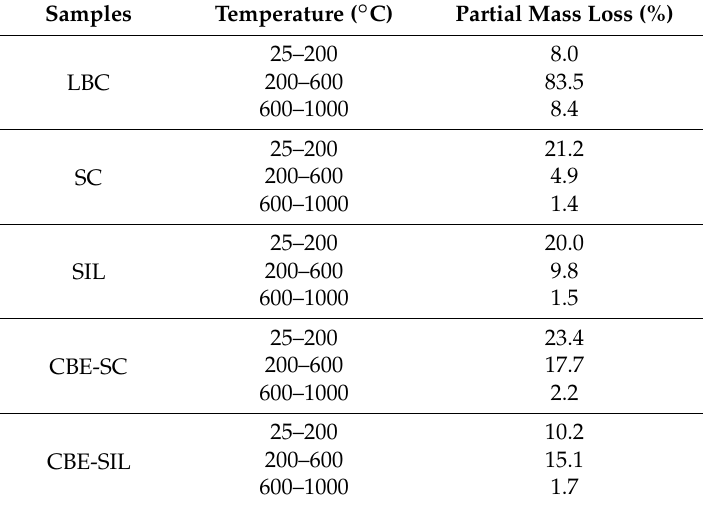
Table 3. Partial mass loss of lipase from Burkholderia cepacia (LBC), control silica xerogel (SC), silica xerogel produced with protic ionic liquid (SIL), lipase immobilized by covalent binding with epichlorohydrin on control silica (CBE-SC) or lipase immobilized by covalent binding with epichlorohydrin onto silica produced with protic ionic liquid